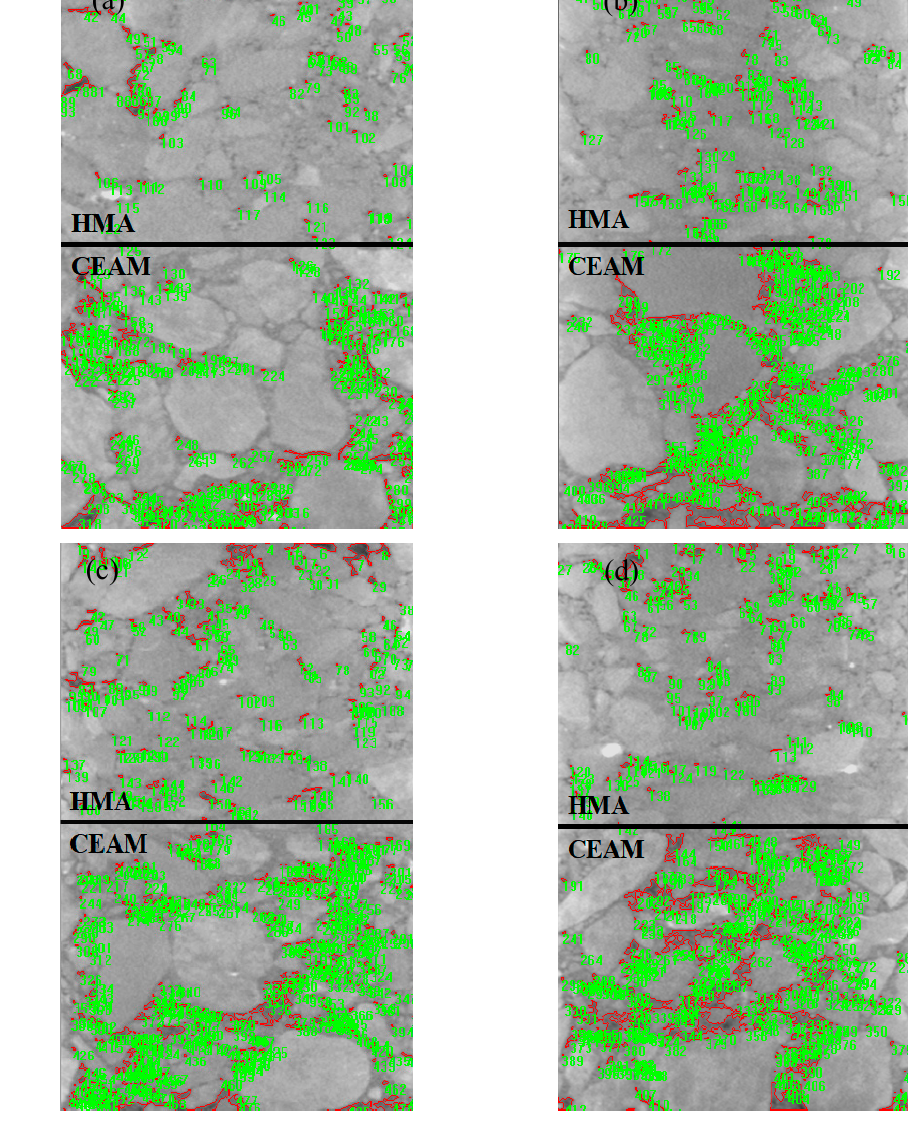
Figure 10. Voids recognition in CT image of C1: ( a ) void recognition in the specimen of 50 mm; ( b ) void recognition in the specimen of 100 mm; ( c ) void recognition in the specimen of 150 mm; and ( d ) void recognition in the specimen of 200 mm.